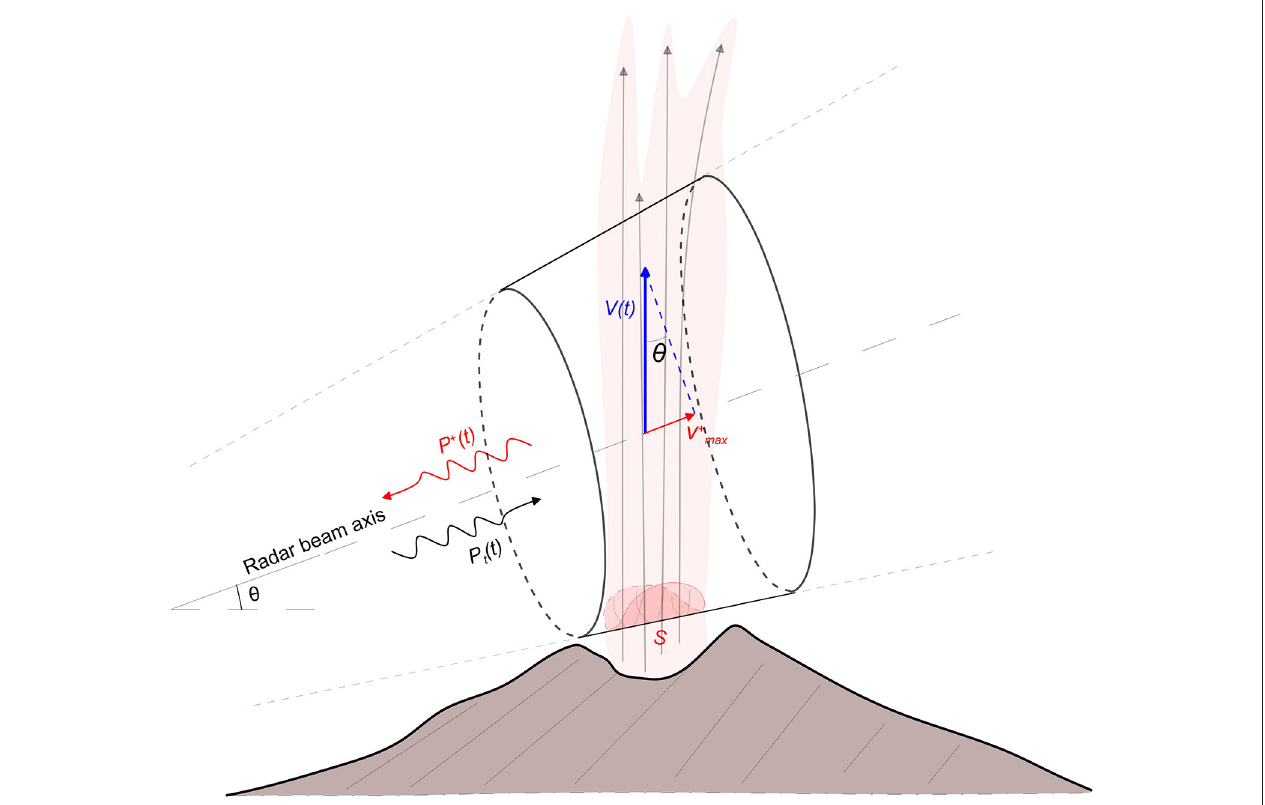
FIGURE 2 | Sketch of the physical model to compute the mass eruption rate from the power and velocity parameters measured by the radar. S defines the (arbitrary) entry surface of the ejecta at the bottom of the radar beam. V ( t ) is the ejected tephra velocity in the beam, assumed vertical, and v + max its component along-beam, as measured by the radar. θ is the radar beam elevation angle. P t ( t ) is the peak power transmitted into the atmosphere by the radar, and P + ( t ) the power backscattered from ejecta having a positive radial velocity, supposedly ascending vertically, in a range gate above the emission